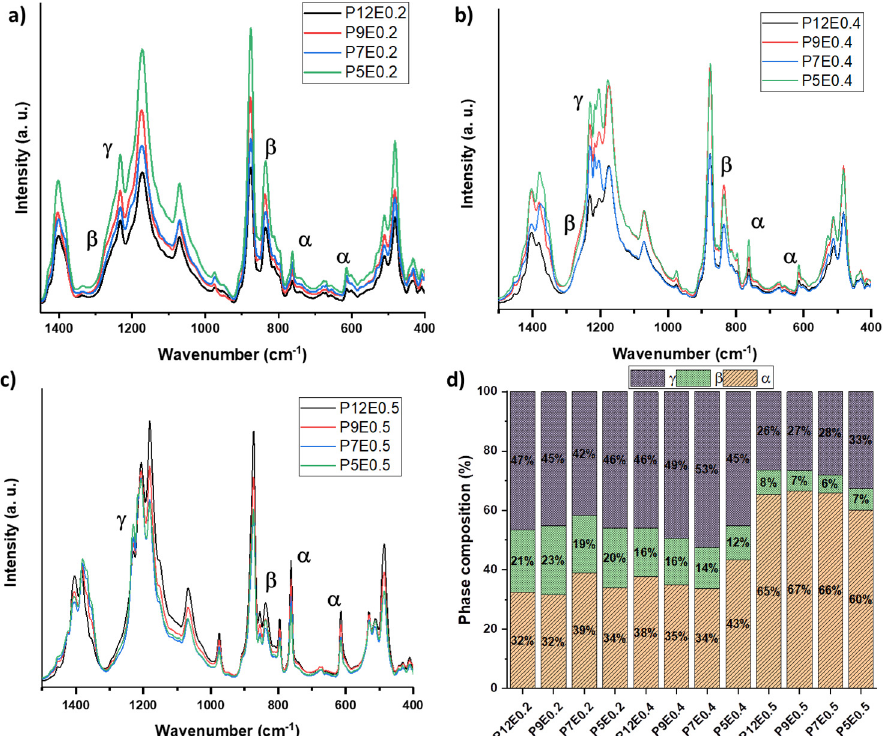
Figure 4. ( a ) FTIR spectra of the PVDF aerogels prepared with a x EtOH = 0.2; ( b ) FTIR spectra of the PVDF aerogels prepared with a x EtOH = 0.4; ( c ) FTIR spectra of the PVDF aerogels prepared with a x EtOH = 0.5; ( d ) quantitative phase composition of all the PVDF aerogels prepared by using DMF as solvent and EtOH as non-solvent.